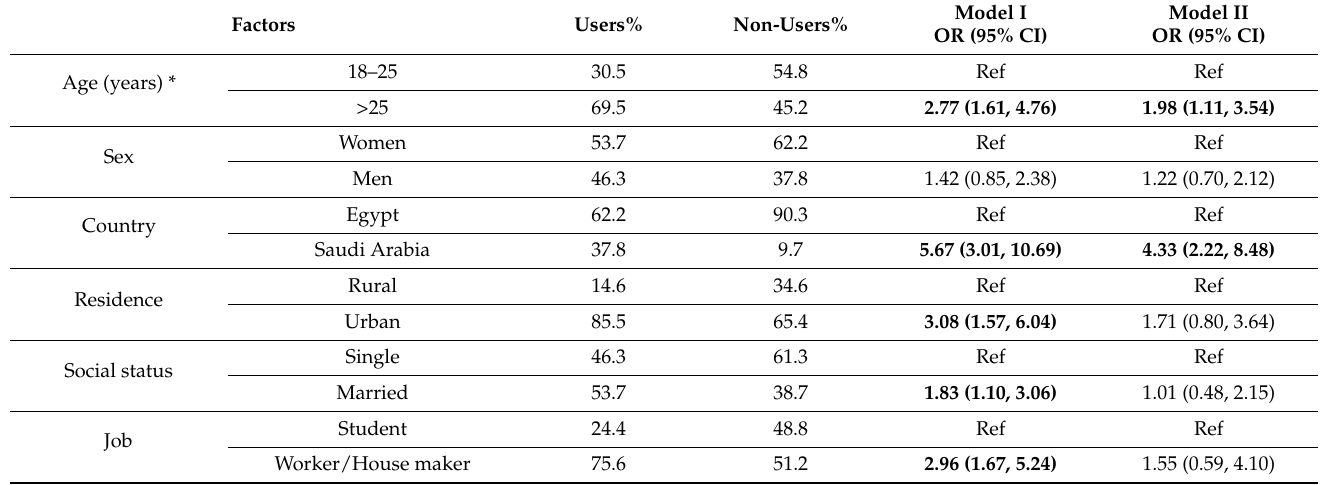
Table 2. Factors associated with mHealth app